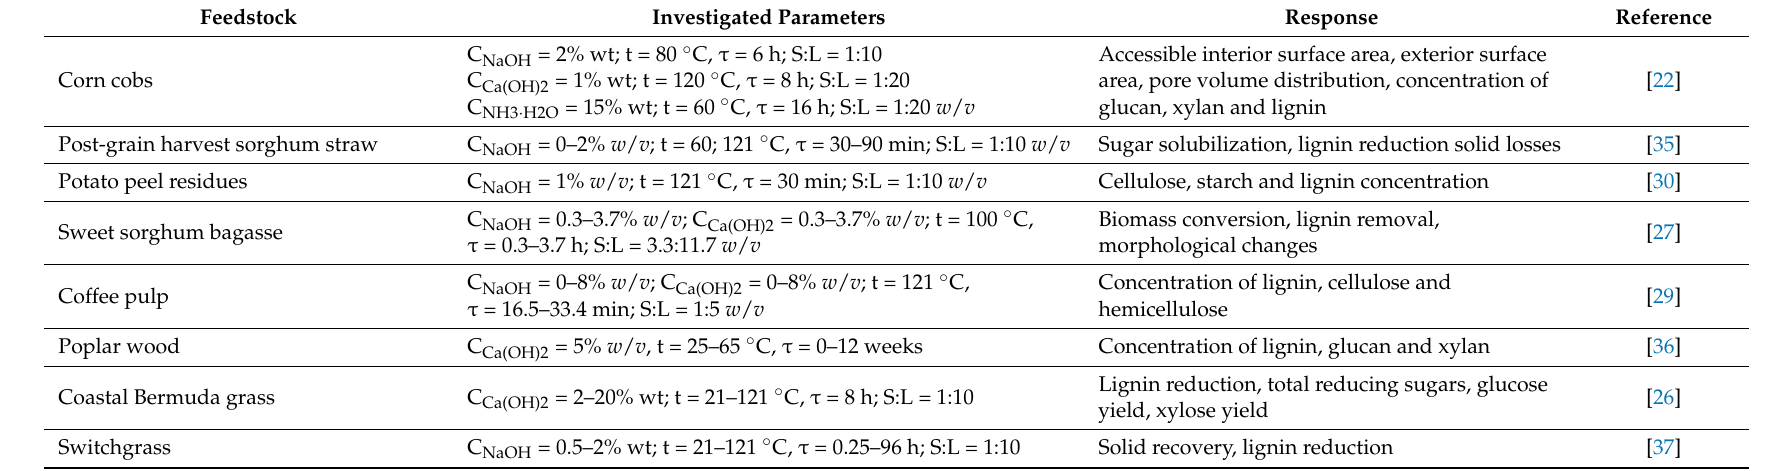
Table 1. Selected research on alkaline pre-treatment of lignocellulosic biomass.